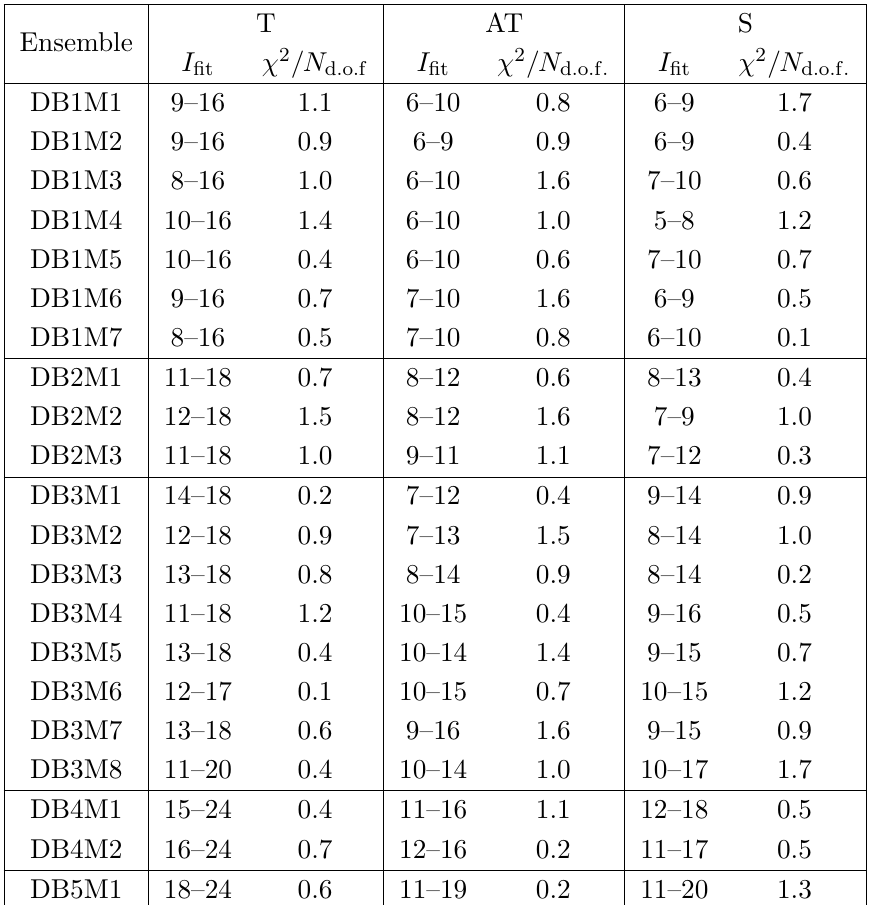
Table 13. Fitting intervals of the Euclidean time I (cid:12)t = [ t i ; t f ] used in the single-exponential (cid:12)t of the measured correlators for T, AT and S mesons, where the same N con(cid:12)gs and (cid:14) traj in table 12 are considered. We carry out a correlated (cid:12)t using standard (cid:31) 2 minimisation. We show the